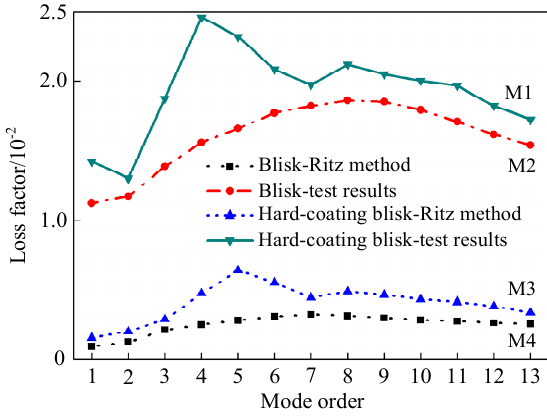
Figure 7. Modal loss factors of the blisk with or without hard ‐ coating.